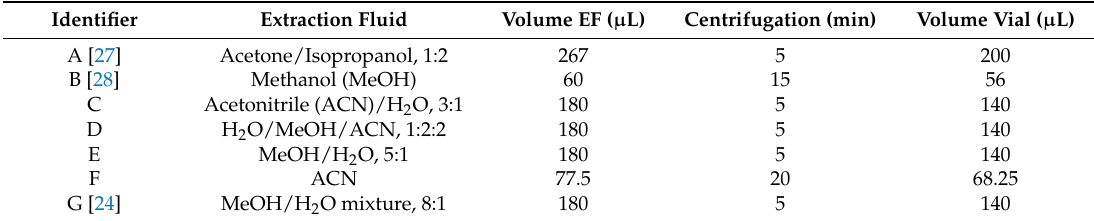
Table 2. Overview of tested metabolite extraction protocols from plasma A–G, summarizing the composition of the extraction fluid (EF), the required volume, the duration of centrifugation, and the transferred volume into the GC